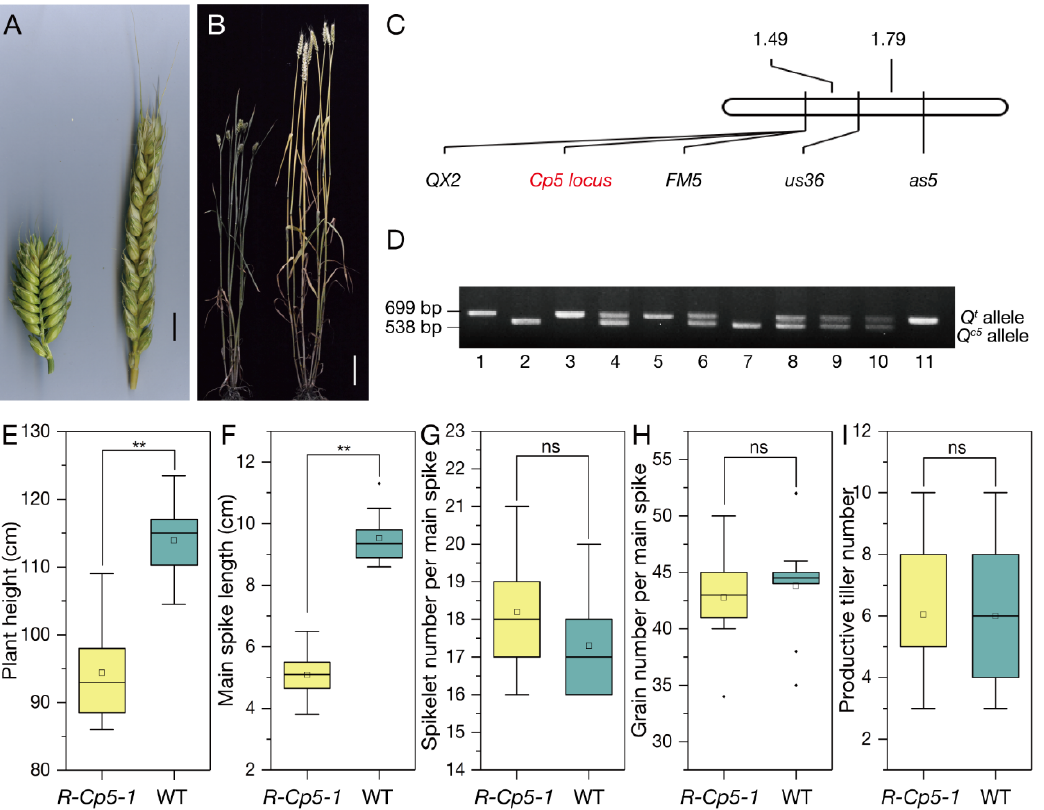
Figure 1. The mutant phenotype is controlled by the Cp5 locus. ( A ) Spikes of R-Cp5-1 (left) and the wild-type (WT) control (right). Scale bar, 1 cm. ( B ) R-Cp5-1 (left) and WT (right) plants. Scale bar, 10 cm. ( C ) Segregation analysis of the Cp5 locus. ( D ) Polymorphic molecular marker between Q t and Q c5 , which co-segregated with the compact spike trait. Lane 1: QZ96; Lane 2: R-Cp5-1 ; Lanes 3–11: representative F 3 individuals from R-Cp5-1 /QZ96. ( E – I ) Comparison between R-Cp5-1 and WT in terms of the plant height, spike length, spikelet number per spike, grain number per spike, and tiller number ( n = 20; **, p ≤ 0.01; ns, not significant).